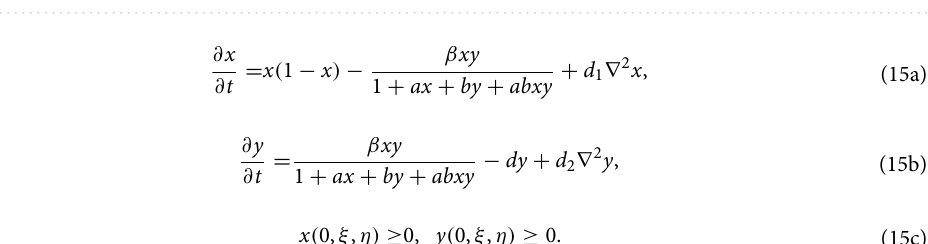
Figure 4. (Weak Allee effect): this figure represents phase portraits of (8) with three positive equilibria.The attractor equilibria are E 0 and E 3 , three saddle ( E 1 , E 2 and E ∗ 2 ) and one unstable focus E ∗ 1 are shown with filled circles, open circles and square open box, respectively. The stable manifolds of the saddle equilibria ( E 2 and E ∗ 2 ), called the separatrix curves, are presented by solid black curves. stable manifolds of saddle interior equilibrium point E 2 and E ∗ 2 , both of which are drawn with black curves. The parameter values used are given by l = − 2, a = 11, b = 3, d = 0.3, β = 10.5